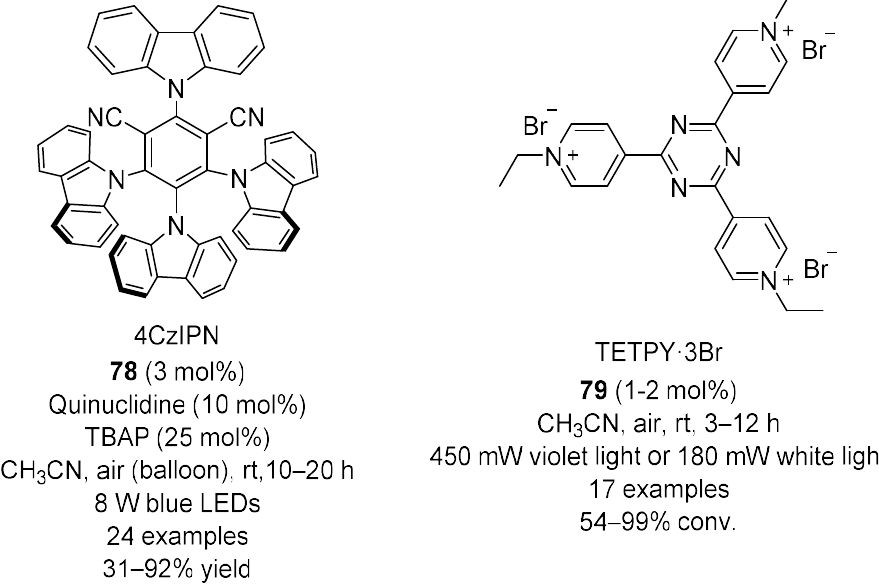
Figure 22. Results obtained in the aerobic photo-oxidation of aromatic and aliphatic alcohols catalyzed by 78 and 79 .